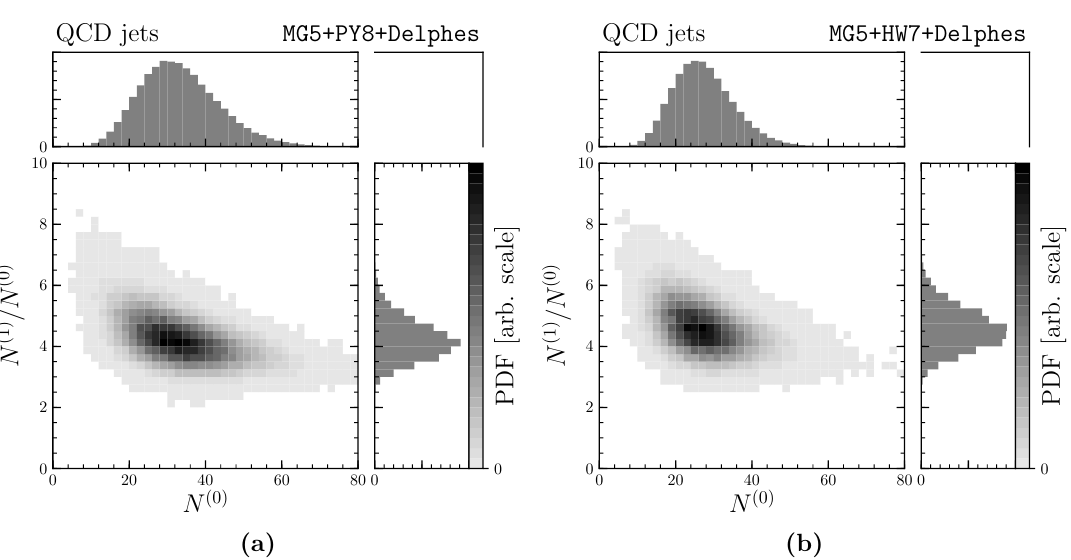
Figure 18. ( N (0) ; N (1) =N (0) ) distributions for (a) PY8 and (b) HW7